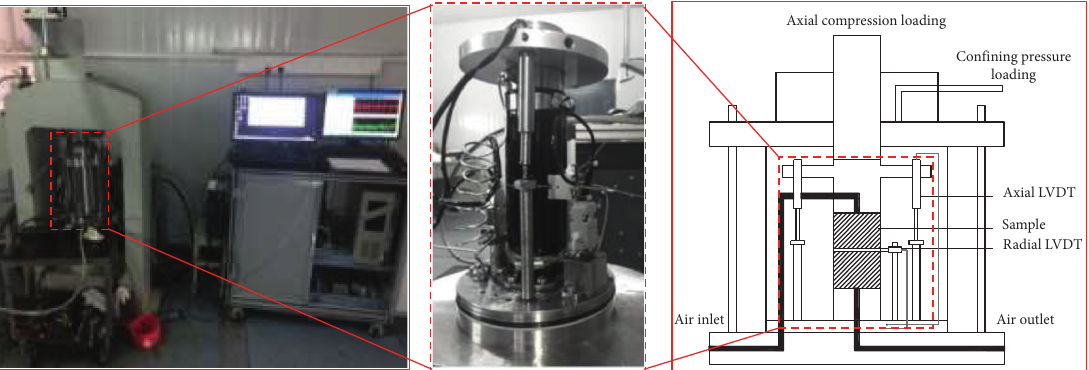
Figure 1: Schematic and actual image of triaxial